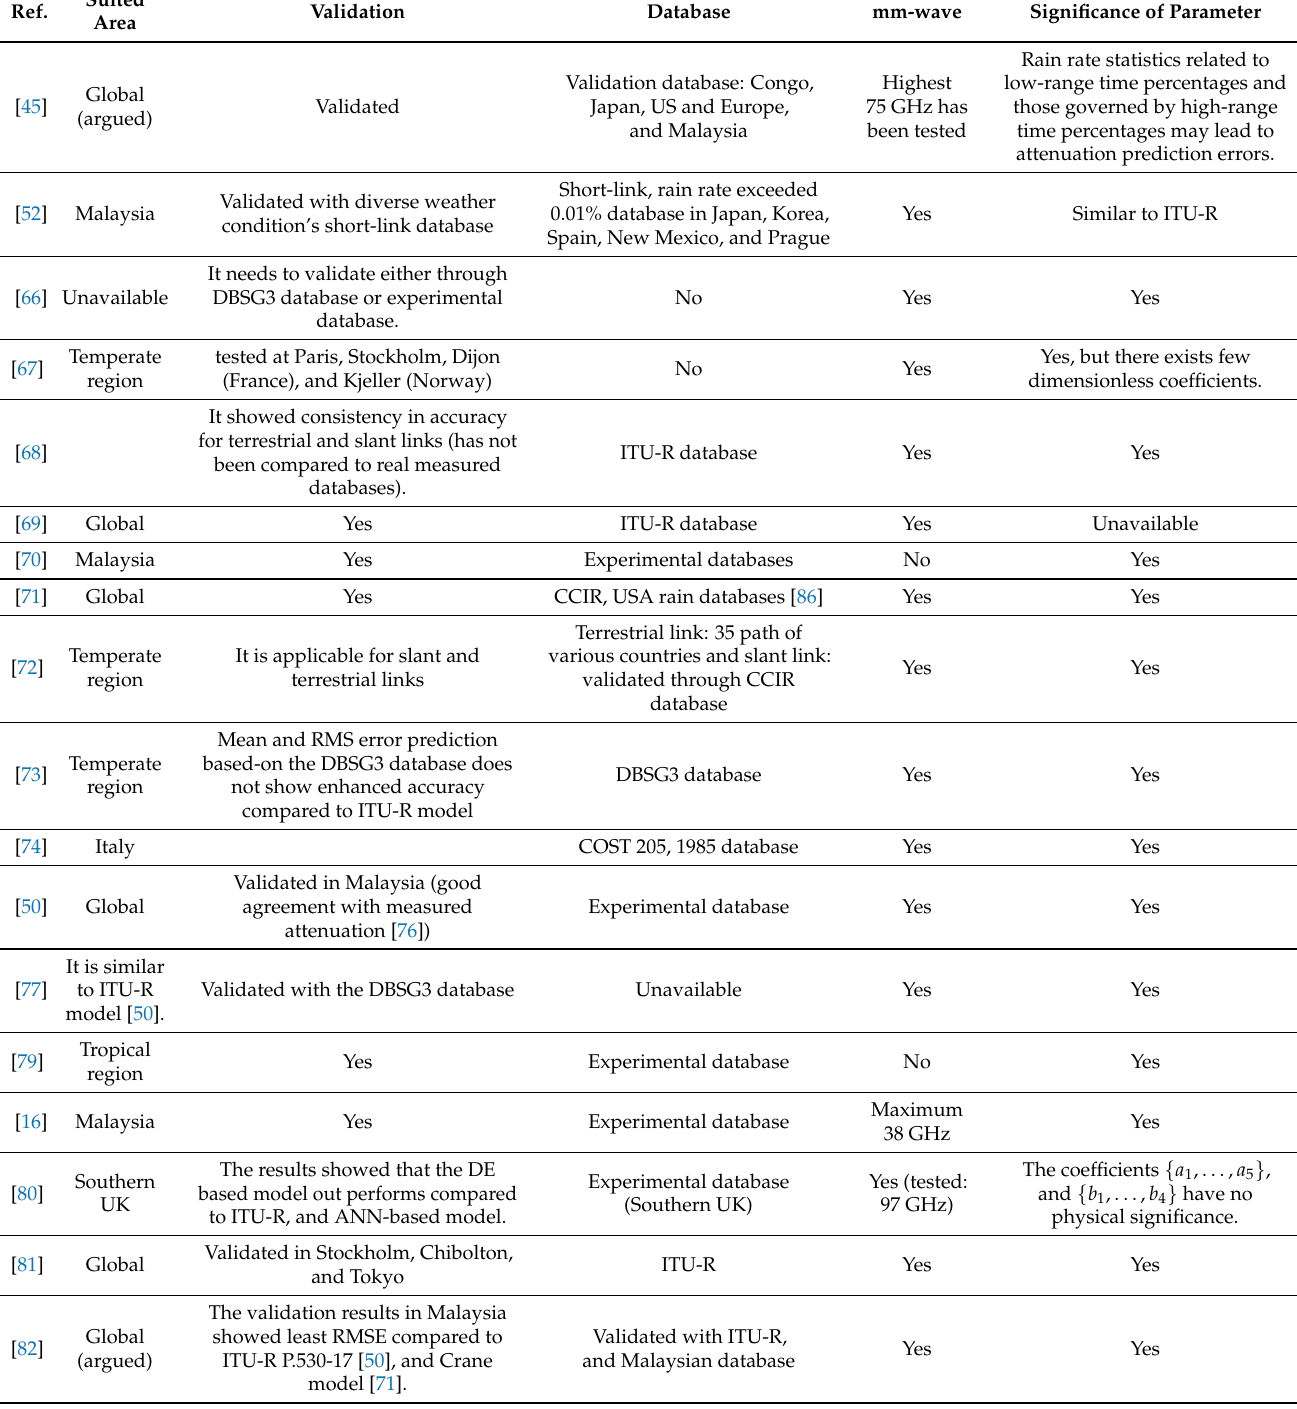
Table 7. Terrestrial rain attenuation models’ few performance